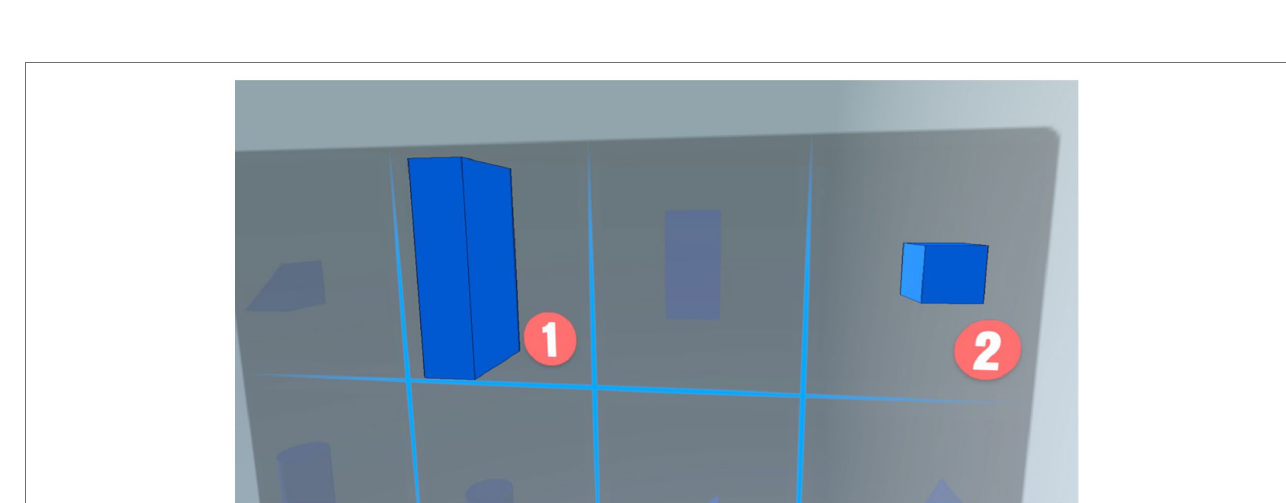
FIGURE 7 | Block option screen of the VR spatial performance assessment